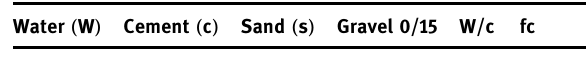
Table 2: Composition of concrete Composition of